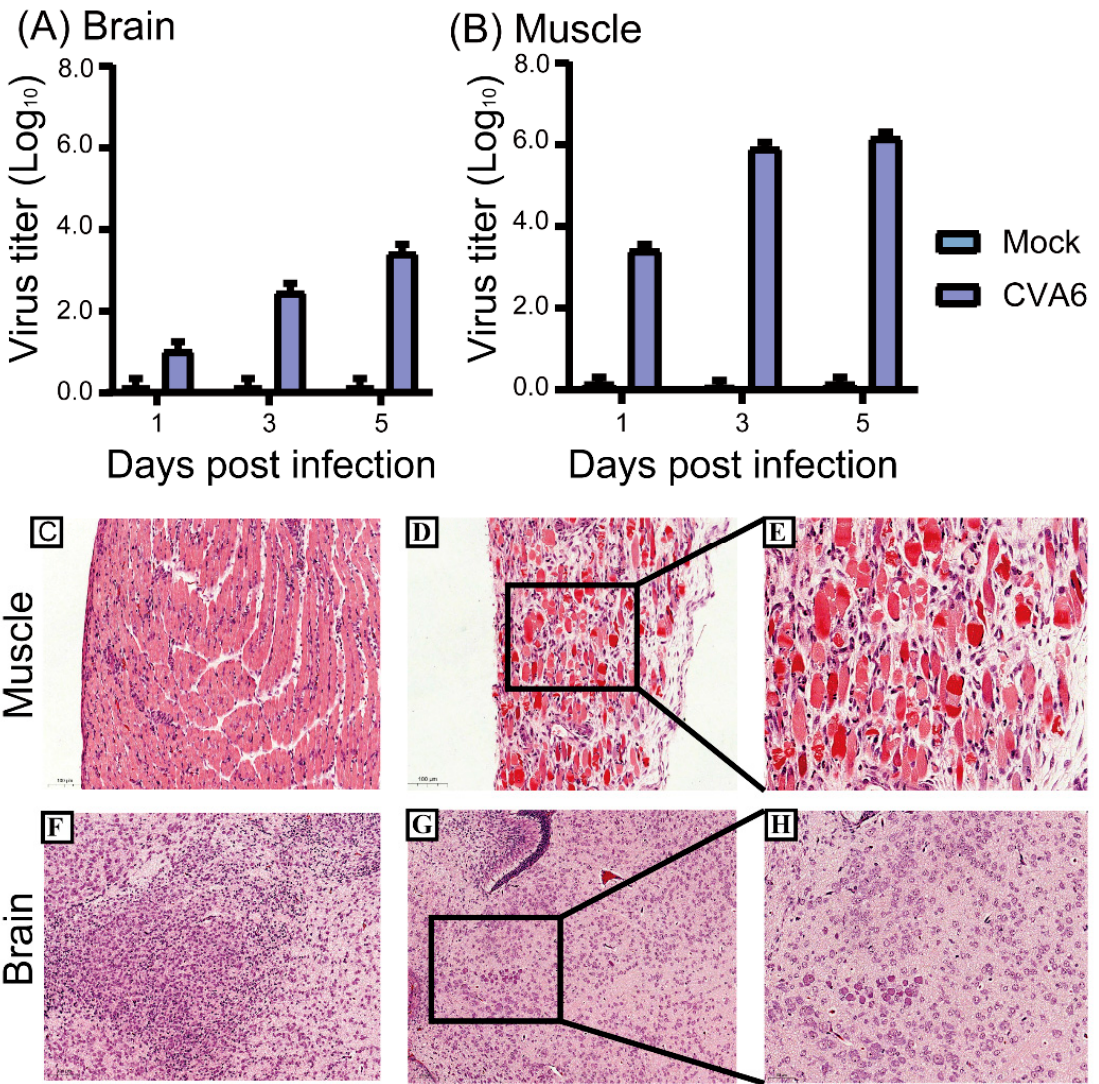
Figure 2. Virus titers in tissues and histopathological changes of 5-day-old mice. Intramuscular injection of the CVA6 strain F219 was performed in 5-day-old ICR mice. Mice were then sacrificed after 1, 3, and 5 days, and virus titers were measured in the brain and muscle tissue ( A , B ). Histopathological analysis showing muscle fiber rupture ( D , E ), cerebral edema, and neuronal cell swelling ( G , H ); no changes were observed in control tissues ( C , F ). The magnification of ( C , D , F , G ) is × 200, and the magnification of ( E , H ) is × 400. The scale bar for ( C , D , F , G ) is 100 µ m, and the scale bar for ( E , H ) is 50 µ m.